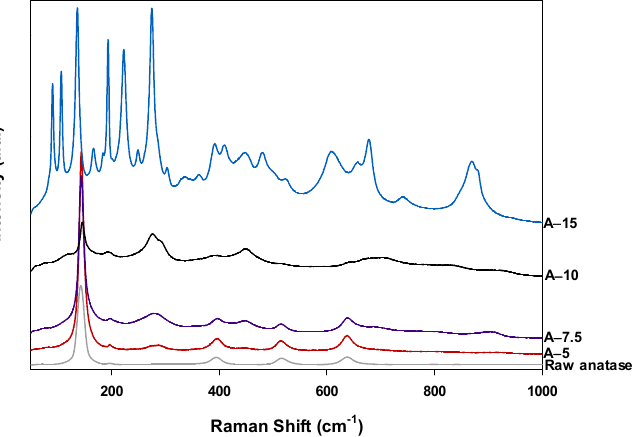
Figure 6. Raman spectra of titania catalysts originating from anatase TiO 2 .